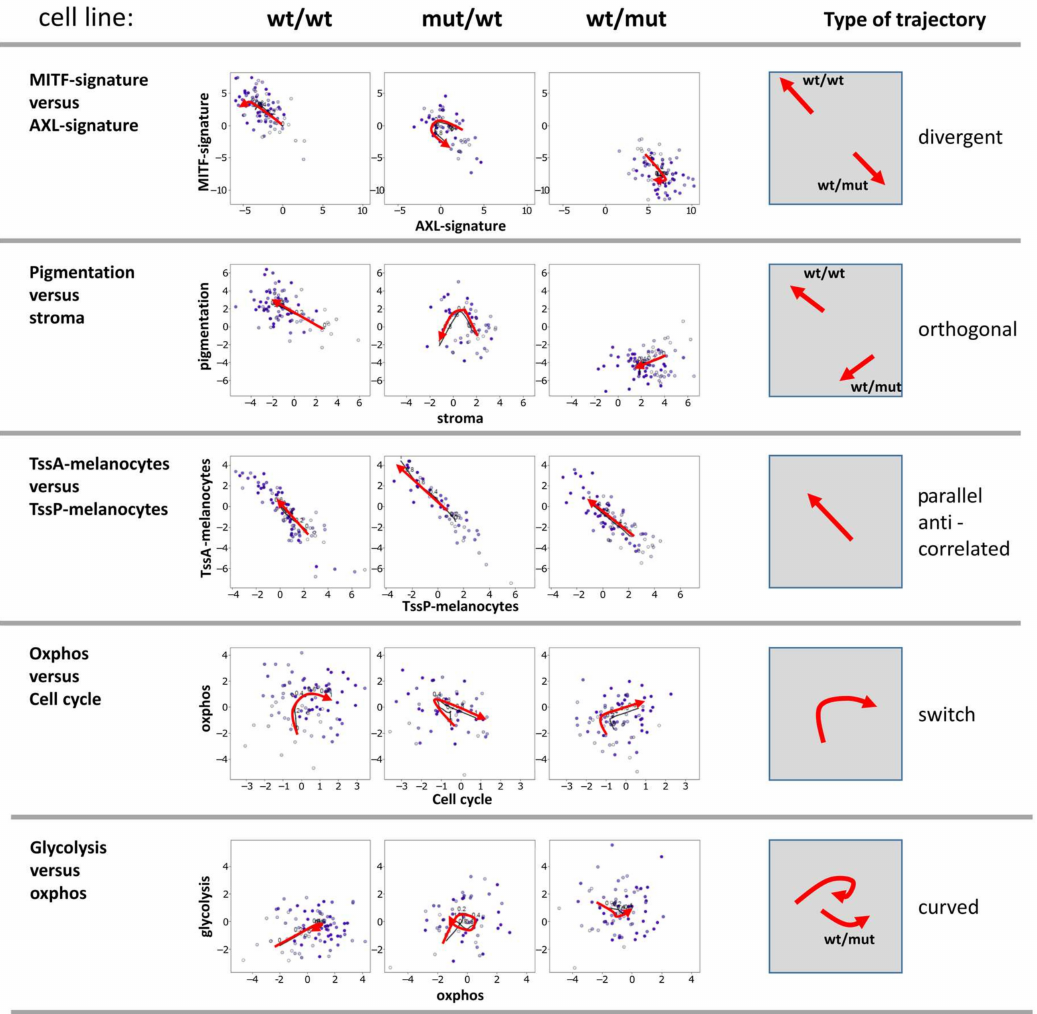
Figure 4. Biaxial trajectories of melanoma progression. Melanoma short-term cultures were analyzed by single-cell RNA-seq and subjected to PT analysis using the Wanderlust algorithm and plotted for biaxial progression trajectories. Plots of pairwise combinations of gene signatures reflect different types of trajectories as schematically indicated in the right part of the